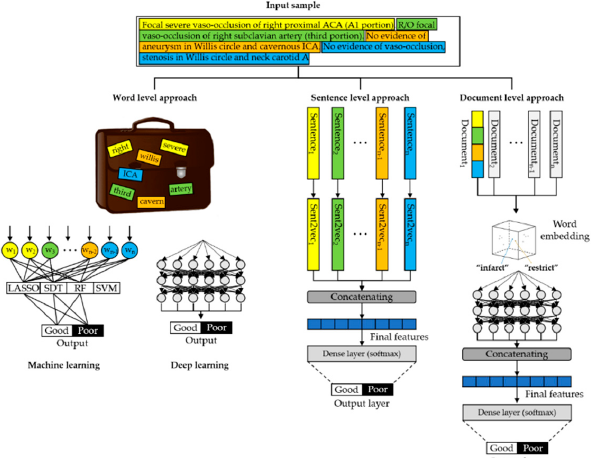
Figure 1. Example of word-, sentence-, and document-level approaches using natural language